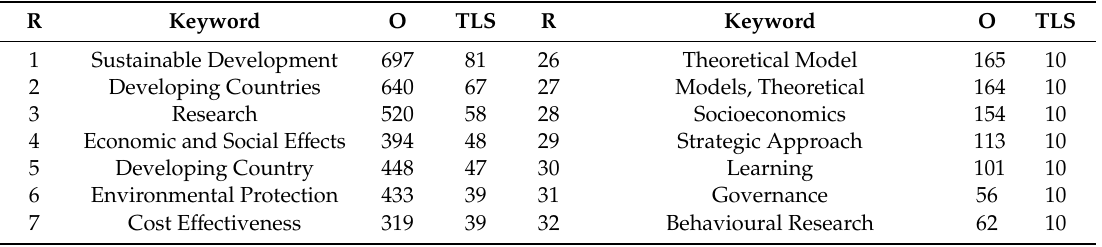
Table 7. Cluster 3. Top 50 keywords